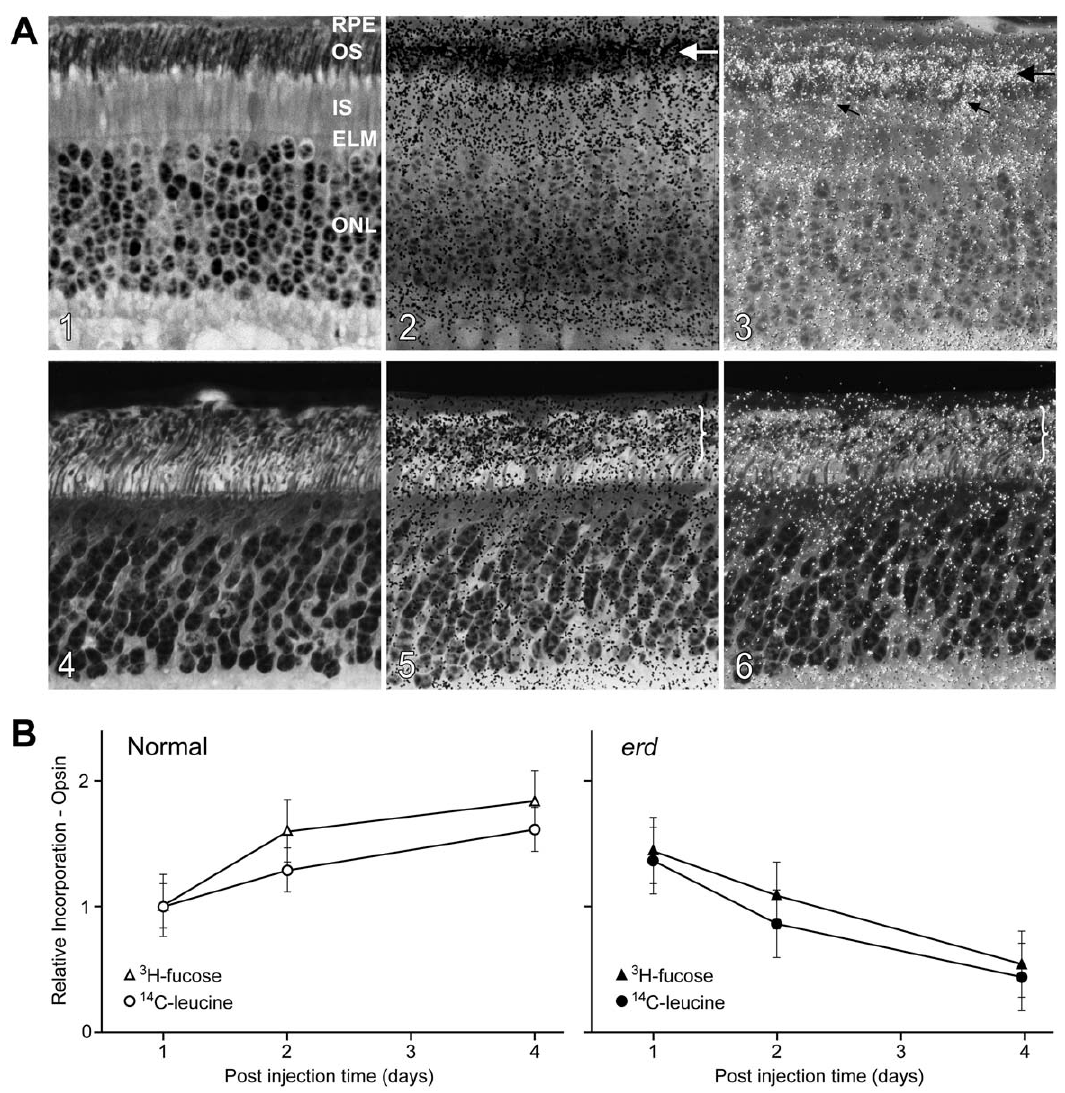
Figure 8. Abnormal outer segment renewal in erd rods. (A1–3) Rod outer segment renewal examined 4 days following intravitreal injection of 3 H-fucose in 10.9 week old normal and (A4–6) erd -affected dogs. The images (A1,A2 and A4,A5) are serial sections taken from the posterior pole of the superior retinal quadrant. The transmitted bright-field autoradiogram (A2) shows in the normal a band of labeling whose leading edge extends to 2/3 of the rod OS length (A2, horizontal arrow) with a trailing tail of radioactivity. This is better visualized in the combined transmitted/epipolarizing image (A3, arrow) that also shows diffuse label in the cone OS (oblique arrows). The mutant retina (A4–6) shows diffuse label at all levels of the OS layer (A5,A6; brackets) that is similar in rods and cones. RPE=retinal pigment epithelium; OS=outer segments; IS=inner segments; ELM=external limiting membrane; ONL=outer nuclear layer. ( B ) Relative incorporation of 3 H-fucose/ 14 C-leucine into opsin at different time points following a single intravitreal injection. All data are normalized to incorporation of label at day 1. The erd outer segments initially take up both labels (day 1), but label intensity decreases at later post injection times, suggesting that label is diffusely distributed through the rod outer segment membranes after discs are formed, and outer segment tips are lost to the RPE by daily shedding/phagocytosis